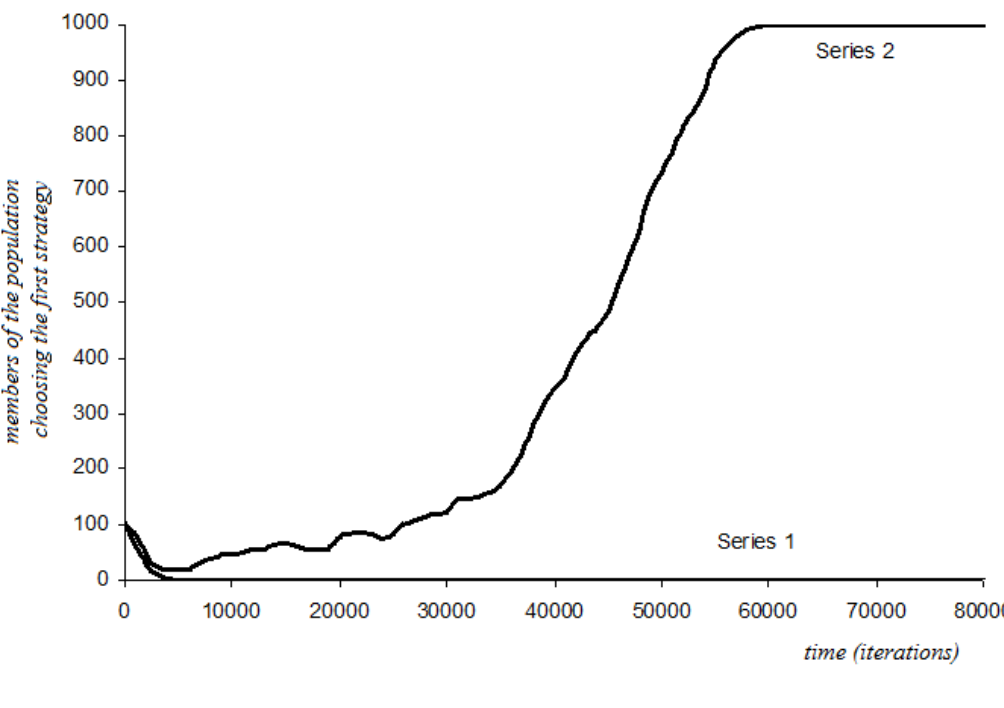
= 0.1. Series 1: a = 0, Series 2: a = 0.1, b = 0